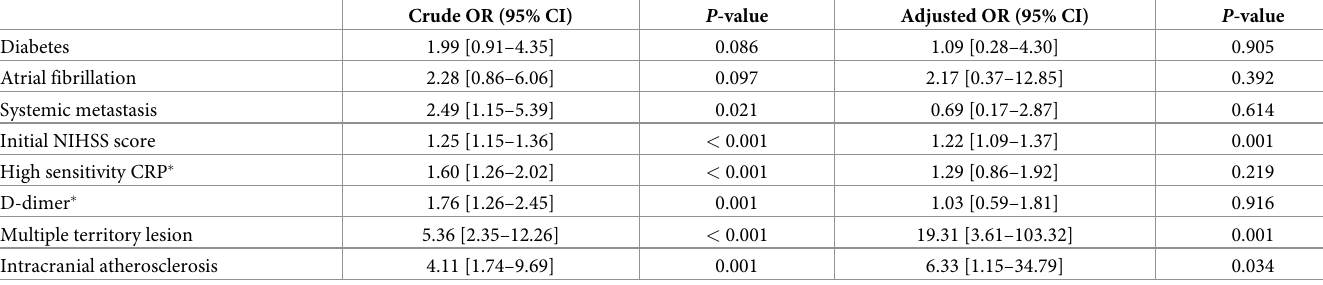
Table 4. Multivariable logistic regression for possible predictor of unfavorable outcomes (3-month modified Rankin Scale score, 3–6).